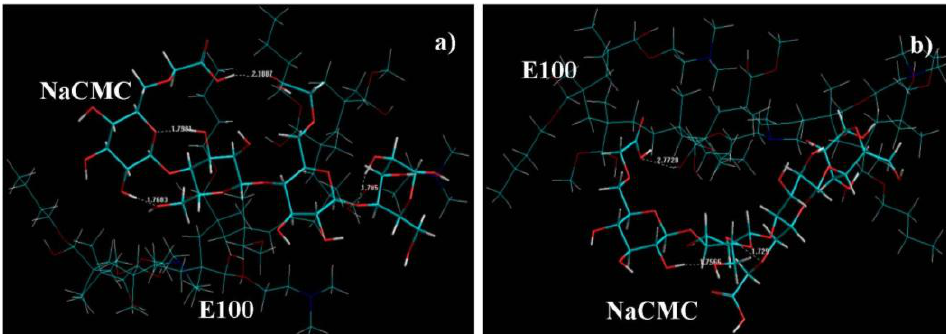
Figure 9. Visualization of geometrical preferences of the NaCMC-E100 (IPEC) complex: ( a ) first stage: initial mixing of two polymers; ( b ) second stage: after 1 h; ( c ) third stage: breaking point; and ( d ) fourth stage: final product after Molecular Mechanics simulations. Color codes: C (cyan), O (red), N (blue) and H